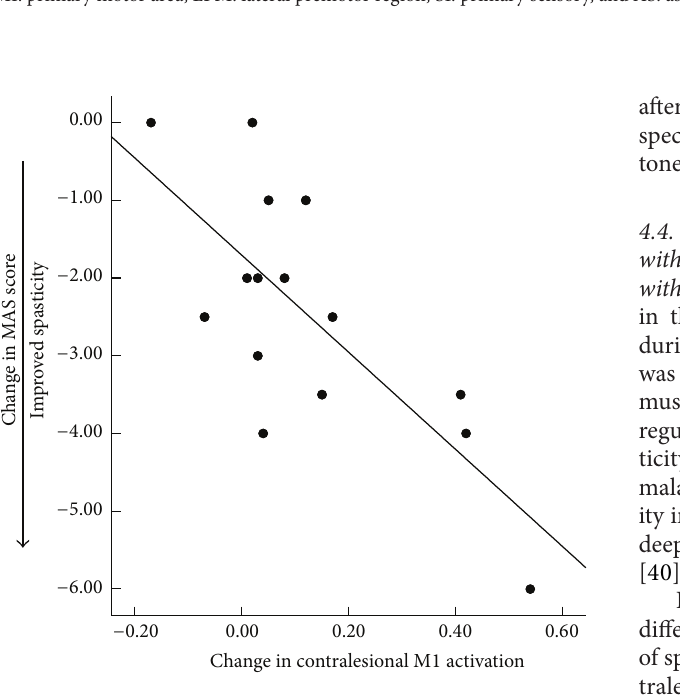
Figure 3: Increase in task-related brain activation correlated with improvement in